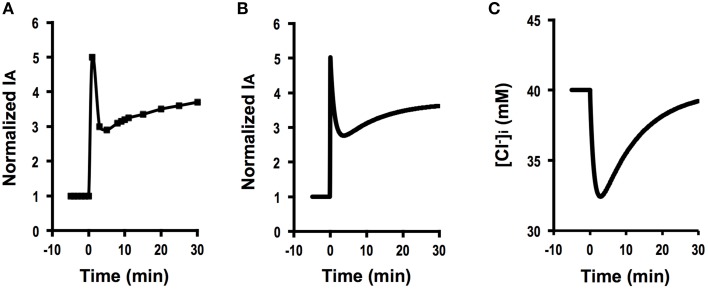
The effect of genistein on Cl− secretion (IA) and simulation of Cl− secretion (IA) and [Cl-]i under a condition where Cl− uptake via a pathway JC changes (JC≠JC0) time-dependently after application of compounds that affect intracellular environments modifying Cl− secretion associated with changes in apical and basolateral Cl− conductance (GA≠GA0 and GB≠GB0) but without any change in the membrane potential (V = V0). (A) The effect of genistein on Cl− secretion (IA). Genistein (100 μM) applied to the apical and basolateral solutions at time = 0 min induced a biphasic increase in IA: (1) the first phase consists of an initial, transient increase in IA followed by a decrease after application of a stimulant at time = 0, and 2) the second phase consists of a gradual increase in IA after IA reaches its minimum value at the first phase toward a steady level larger than the basal level. (B) Simulation of IA in cells secreting Cl− secretion (IA) shown in (A). A stimulant is applied at time = 0 min. Cl− secretion shows a five-fold increase just after application of a compound modifying Cl− uptake via a pathway (JC= 3 JC0), apical Cl− conductance (GA=5 GA0) and basolateral Cl− conductance (GB=4 GB0; GB0=30 GA0) without any change in membrane potential (V = V0) according to Equation (A18). Then, Cl− secretion gradually decreases from its peak. After reaching its minimum value, Cl− secretion again increases toward a steady value shown in Equation (A18). (C) Simulated [Cl-]i of cells secreting Cl− shown in (B). A stimulant is applied at time = 0 min. [Cl-]i transiently decreases after increases in GA and GB followed by a gradual increase due to an increase in JC.